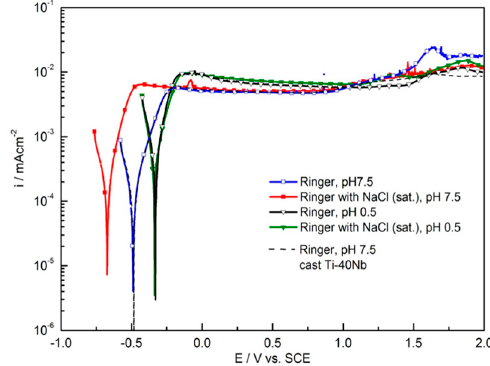
Figure 5. Characteristic potentiodynamic polarization curves of hot-pressed Ti-45Nb samples measured in Ringer solution with and without NaCl addition up to saturation and at different pH values and of reference cast Ti-40Nb sample at pH 7.5.